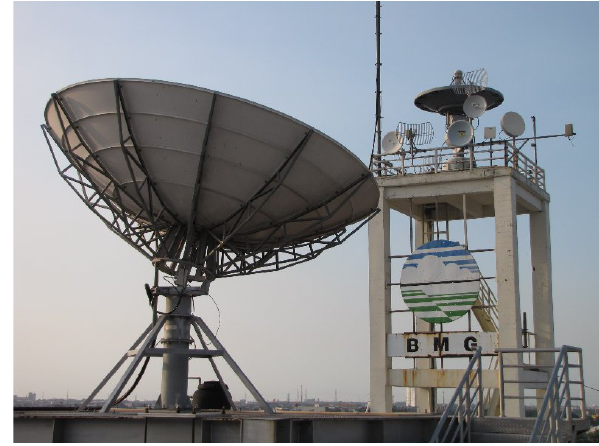
Fig. 8. Coverage area (“footprint”) of the Telkom-2 Satellite, which is used for the sensor network from Maledives to Eastern Indonesia.